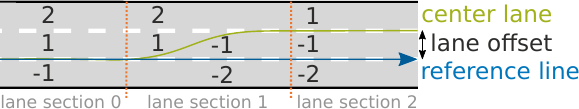
Figure 11. Connected lane boundaries at the lane transitions between multiple